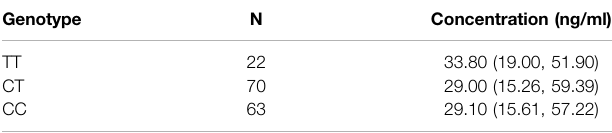
TABLE 3 | Effects of rs1045642 SNPs on rivaroxaban plasma concentration in 155